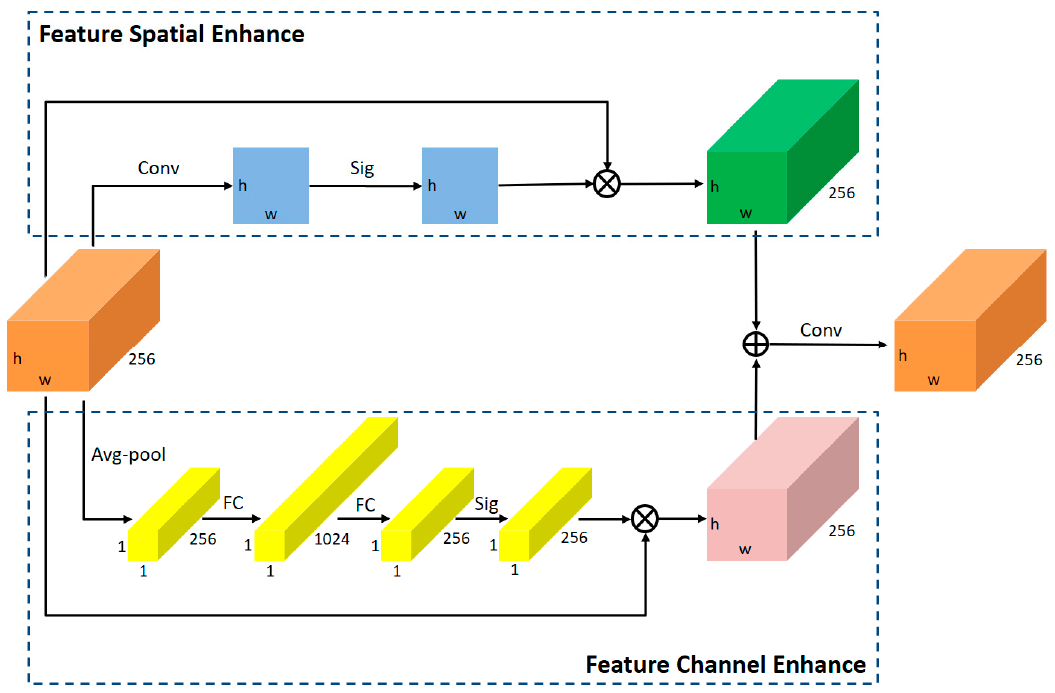
Figure 4. Details of the Feature Enhance Module. Feature spatial enhance (FSE) fuses multi-channel information using a 1 × 1 convolution kernel and normalizes it using a sigmoid function to obtain two-dimensional spatial weights. Feature channel enhance (FCE) obtains a 1 × 256 vector using global average pooling. Then, the vector is calculated by two fully connected layers and normalized using the sigmoid function to obtain the one-dimensional channel weights. Enhanced features from the two approaches are superimposed together, followed by further fusion of the local feature information using 3 × 3 convolution.